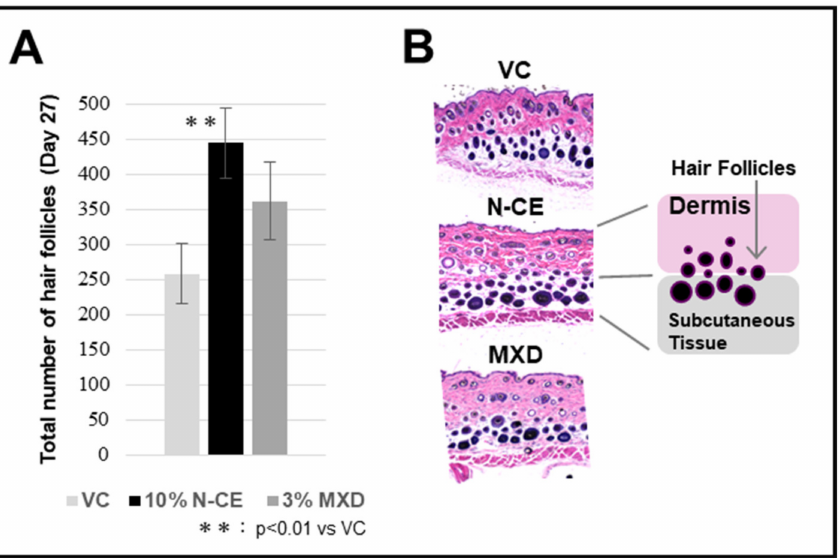
Figure 2. The effect of N-CE and MXD treatments on the number of hair follicles in the C57BL/6 mice. Hematoxylin- and eosin-stained photomicrographs of different groups of whole-layer skin tissue sections of the mouse back. ( A ) The total number of follicles in the dermis and subcutaneous tissue and the number of follicles in the subcutaneous tissue only was measured in section photographs, and the average number of follicles was calculated and plotted. ( B ) Micrographs of the hair follicles of VC control, N-CE, and MXD group. Results were presented as mean ± SD ** p < 0.01 when compared to the respective VC values by Student’s t -test (n =